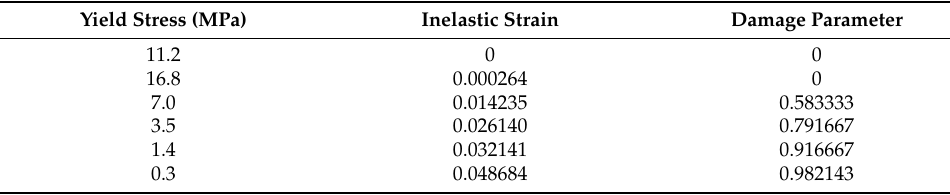
Table 5. Compressive input parameters of PCM.